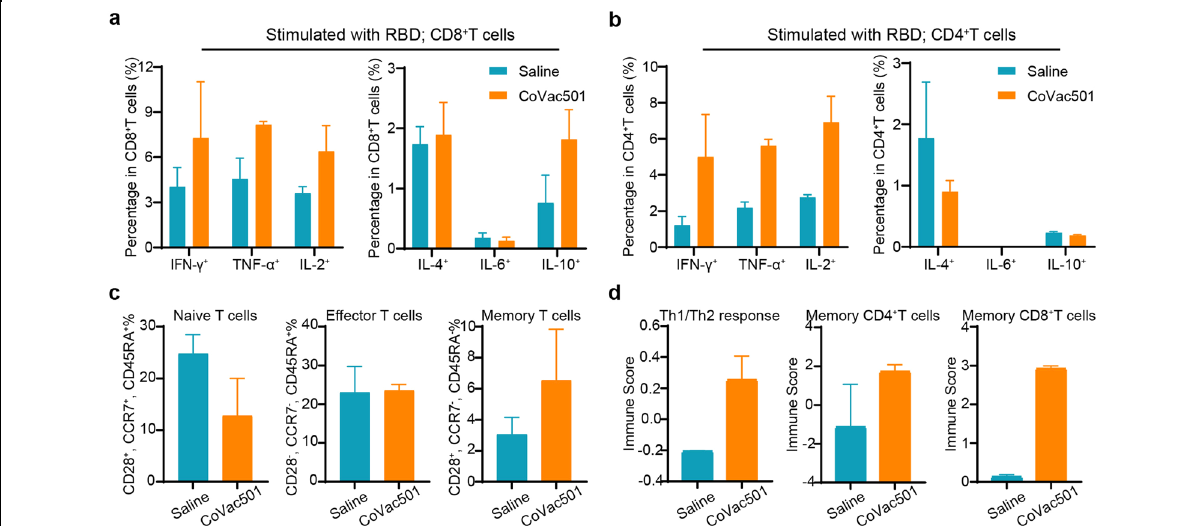
Fig. 5 CoVac501 induced Th1-baised responses and T-cell immune memory in cynomolgus macaques. a , b PBMCs were collected from the monkeys 70 days after the fi rst dose of vaccine and IFN- γ + , TNF- α + , IL-2 + , IL-4 + , IL-6 + , and IL-10 + intracellular cytokine staining assays by fl ow cytometry for CD8 + T ( a ) and CD4 + T ( b ) cells in response to RBD after 8 h antigen stimulation. c PBMCs were collected from monkeys 42 days after the fi rst dose of vaccine and naive T cells (CD28 + , CCR7 + and CD45RA + ), effector T cells (CD28 – , CCR7 – , and CD45RA + ) and memory T cells (CD28 + , CCR7 – , and CD45RA – ) were tested by fl ow cytometry. d RNA sequencing results were analyzed for immune cell levels and immune processes through the xCell or Molecular Signatures Database. All data are presented as the means ±